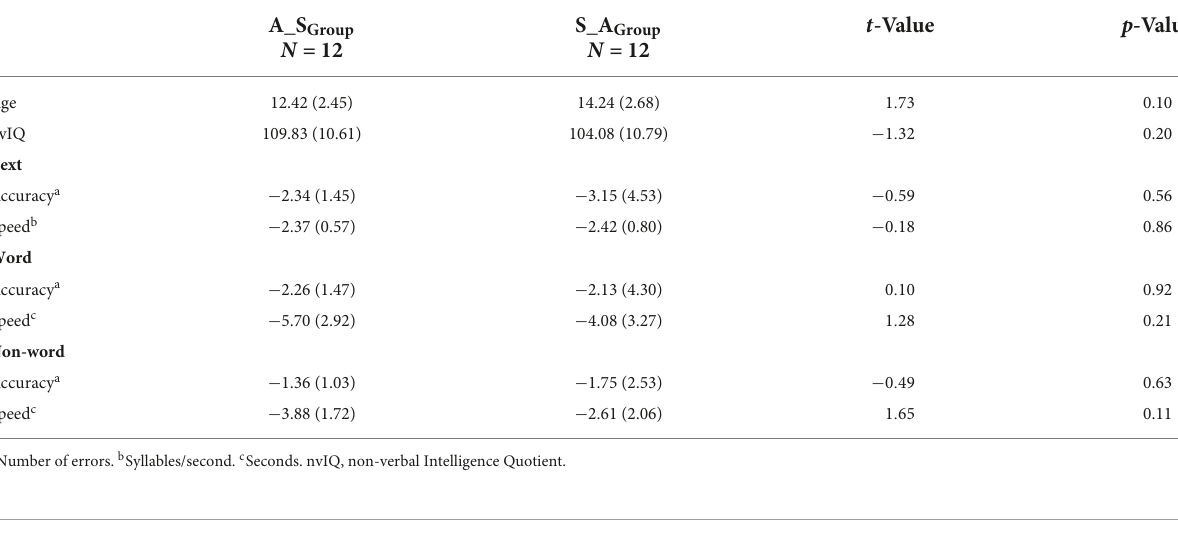
TABLE 1 Means (SDs) of age, nvIQ, and z -scores of norm-referenced reading measures at baseline in the A_S Group and S_A Group .